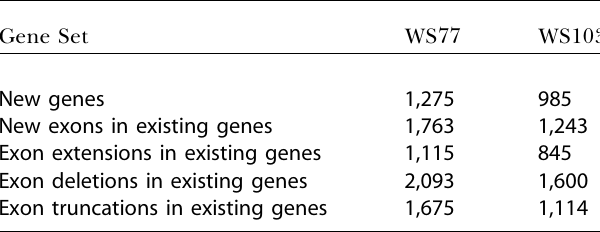
Table 11. Updating the C. elegans Gene Set Using C.